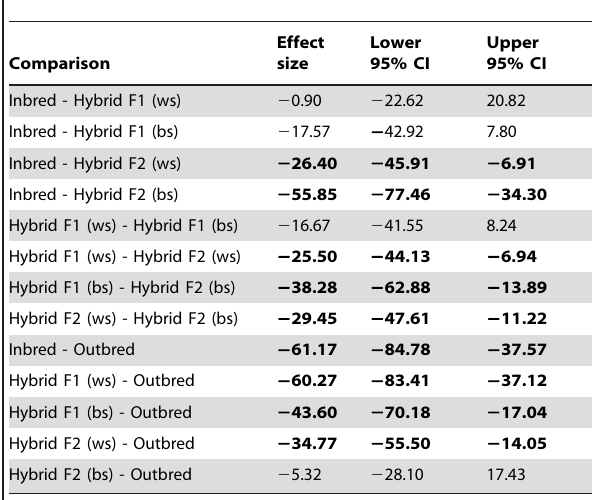
Differences are significant if the 95% CIs do not include 0 and are indicated in